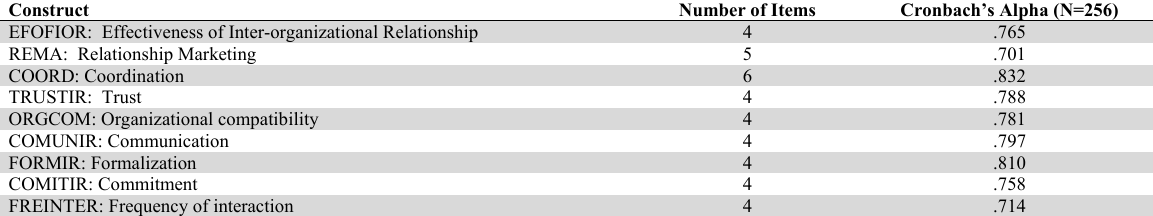
Summary statistics for measures-Reliability